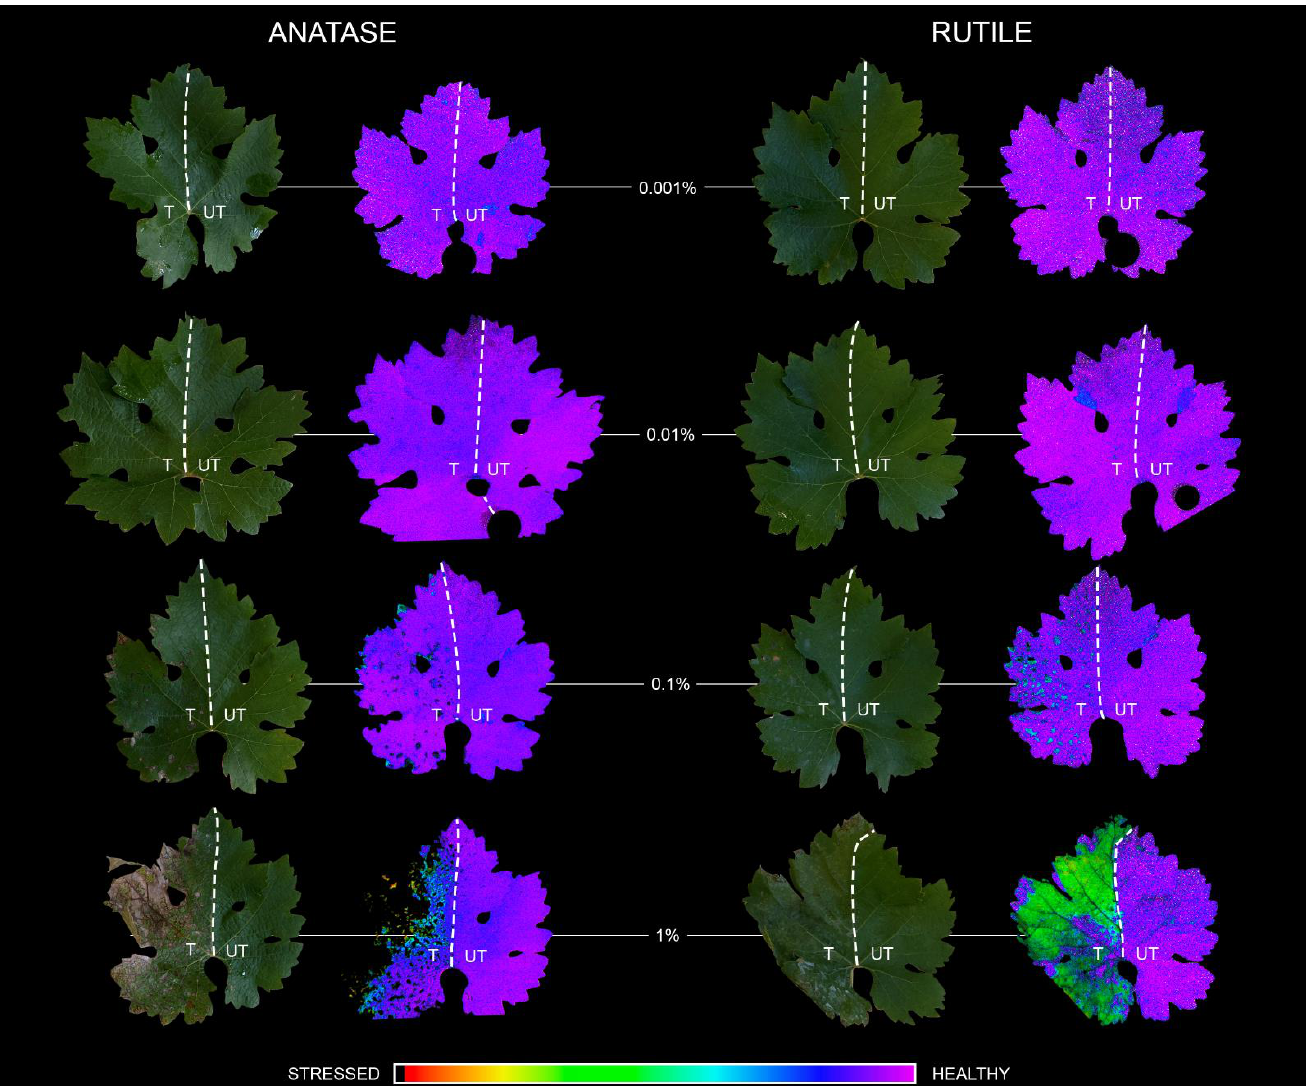
Figure 4. Digital and color-coded chlorophyll fluorescence images of anatase ( left pair ) and rutile ( right pair ) TiO 2 NCs-treated Cabernet Sauvignon grapevine leaves along a concentration gradient (0.001, 0.01, 0.1, and 1 w / v %). TiO 2 NCs treatments were carried out by masking the leaves along the midvein, which divided them into two parts (dashed line): treated side on the left (T), untreated control on the right (UT). The false-color coding refers to the maximal quantum yields of photosys- tem II (Fv/Fm). The color scale depicted at the bottom of the figure represents the range between stressed and healthy stages.